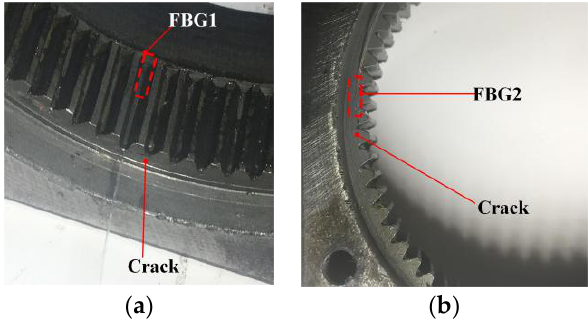
Figure 23. Installation of ( a ) FBG1 and ( b ) FBG2 under a tooth crack.